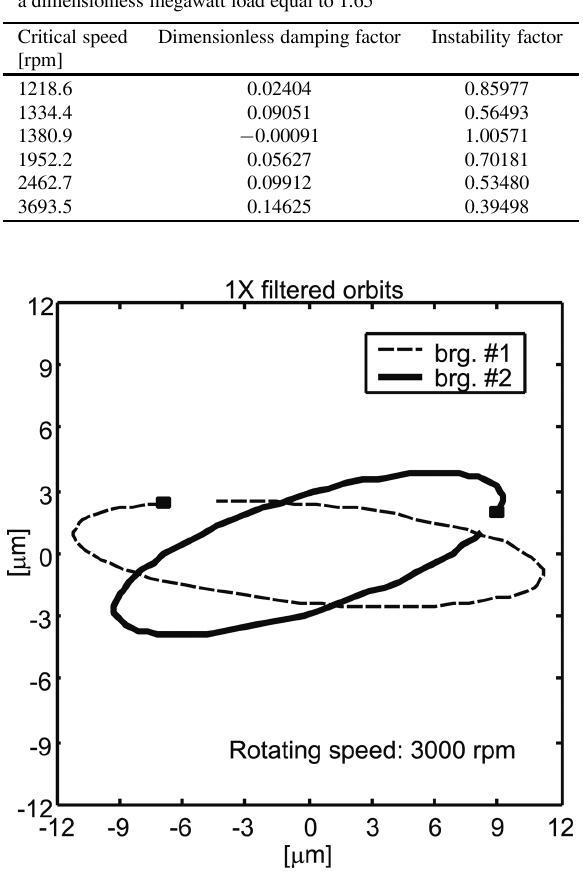
Fig. 21. 1X fi ltered journal orbits measured at bearings #1 and #2 few minutes before an instability